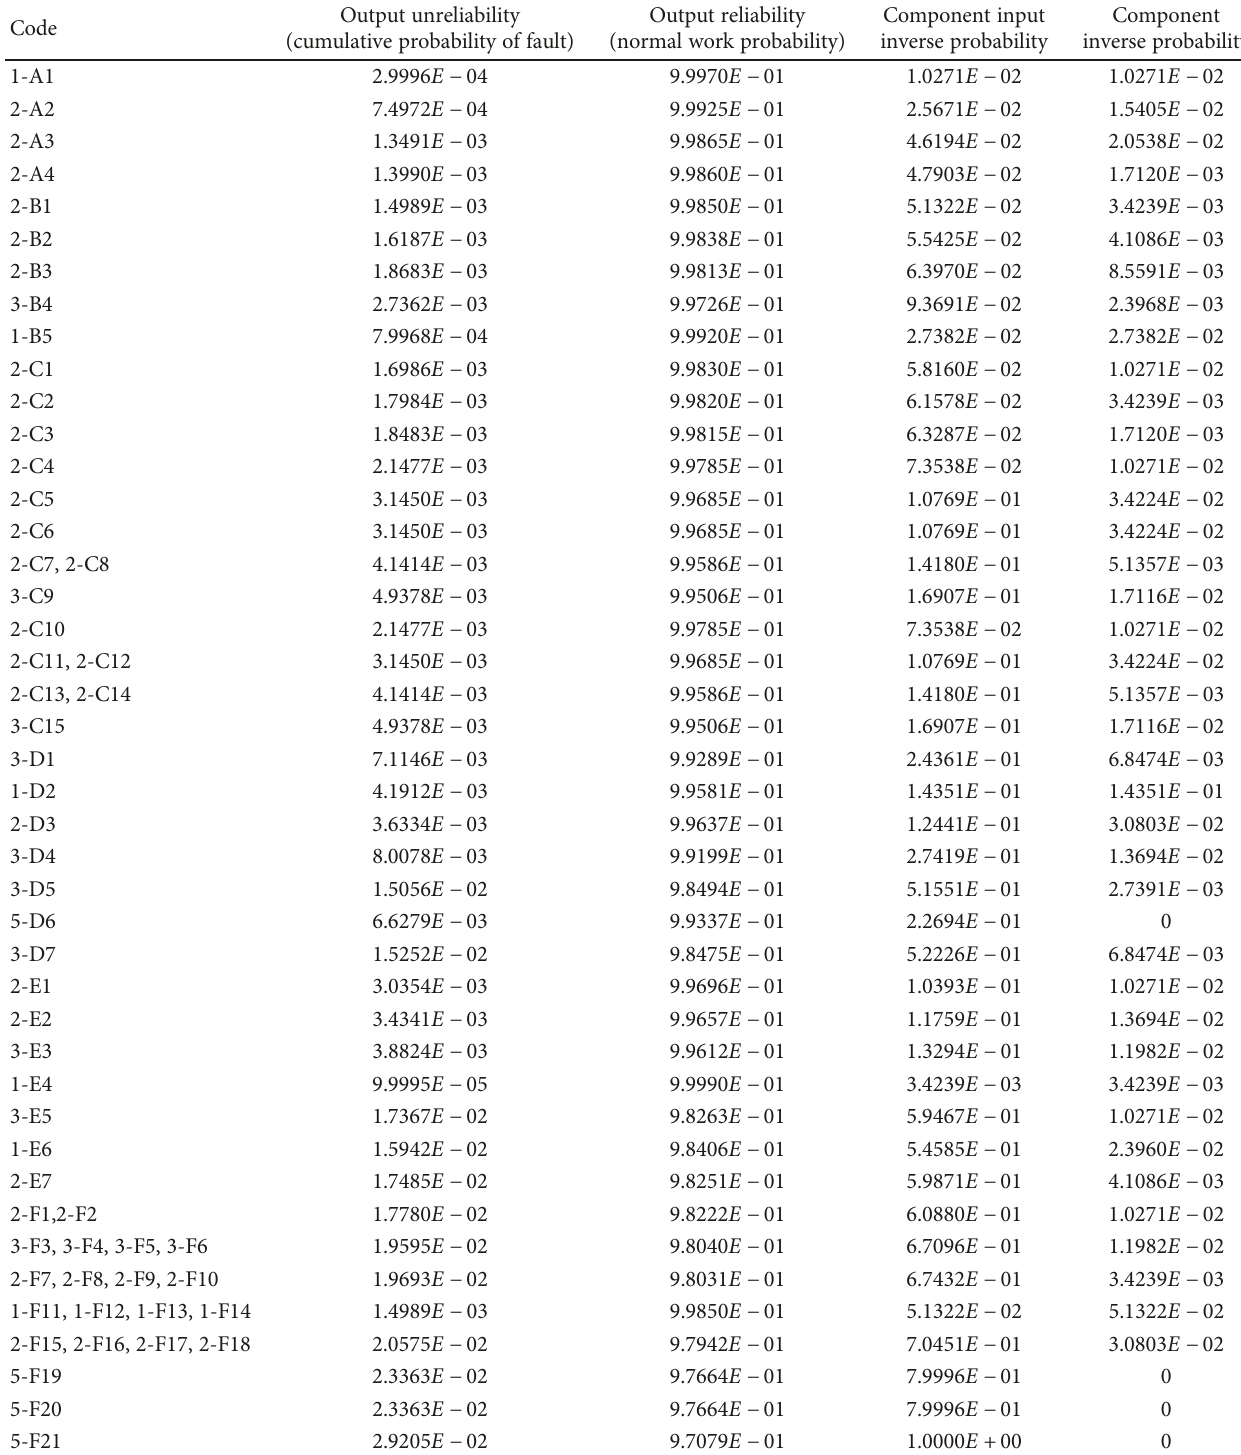
Table 3: Safety analysis results for the braking